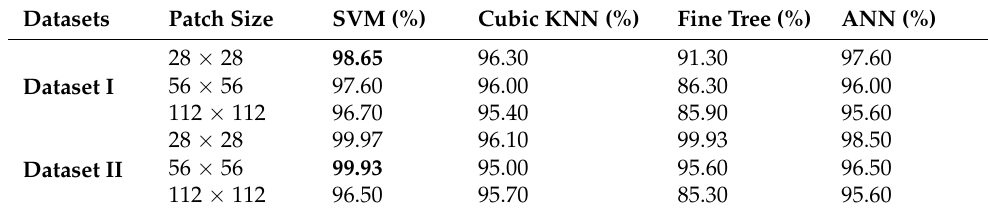
Table 3. Classification performance obtained for the proposed method using various classifiers.